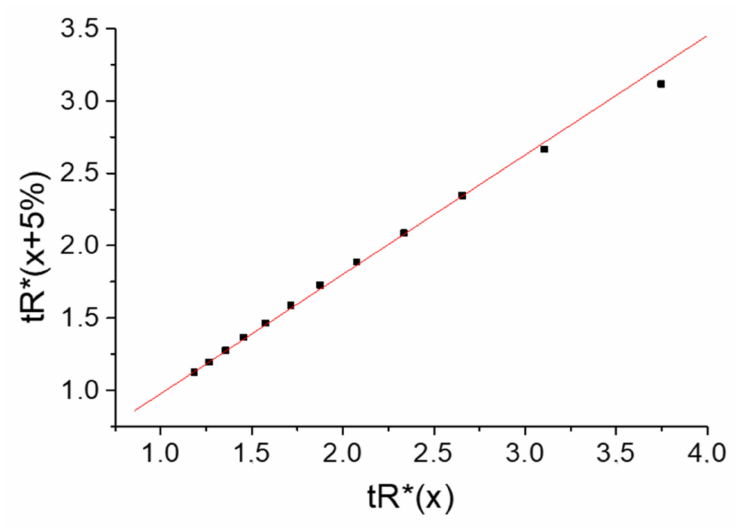
Figure 3. Plot of the recurrent approximation of the superposition of two nonlinear hyperbolical dependencies t R ( x ) (numerical modeling). The area of maximal t R *-values shows visible deviations from